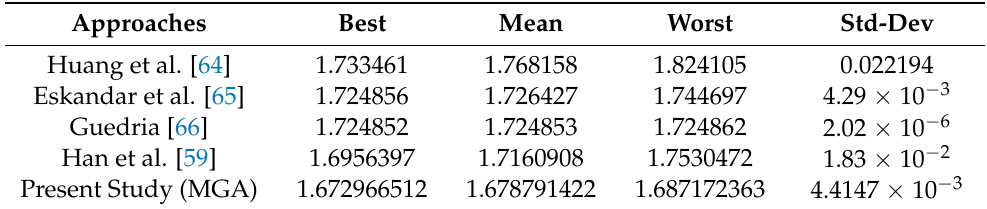
Table 11. Statistical results of different approaches for the welded beam design